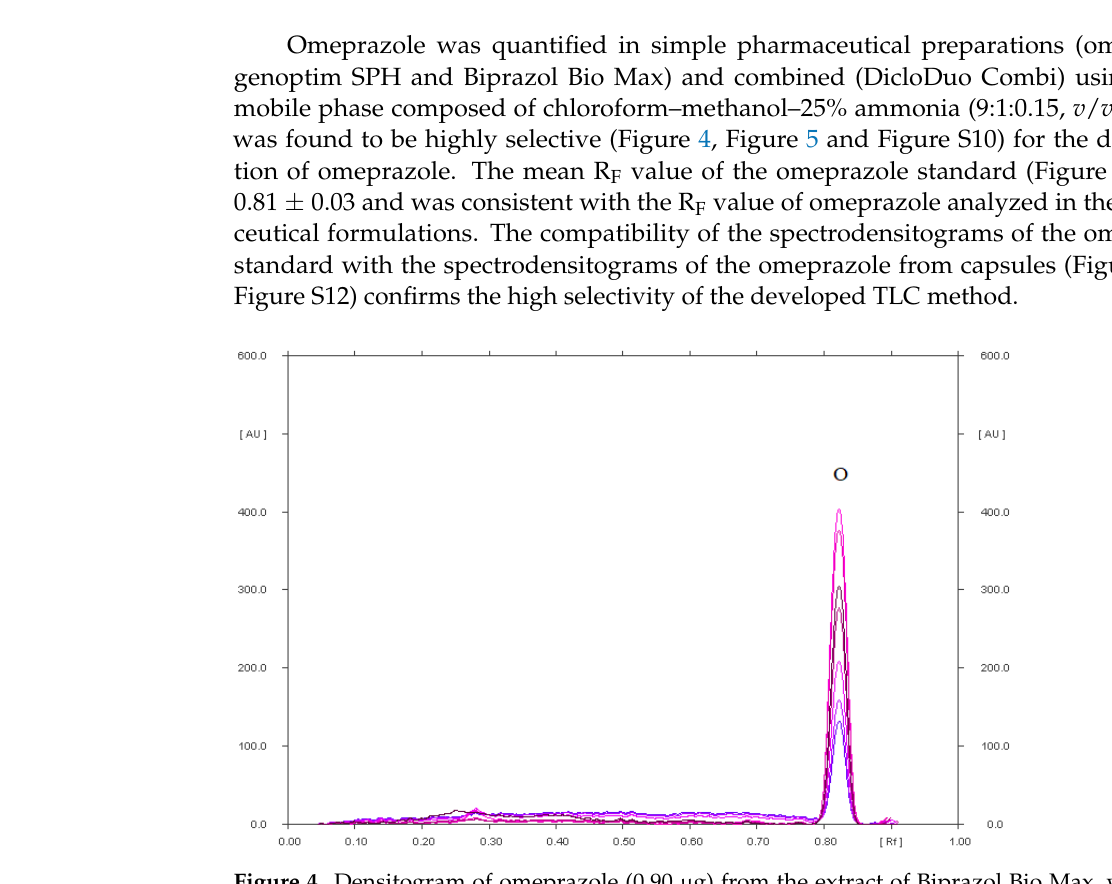
Figure 4. Densitogram of omeprazole (0.90 µg) from the extract of Biprazol Bio Max, which was analyzed on silica gel using a mobile phase: chloroform – methanol – ammonia (36:4:0.60, v / v / v ).